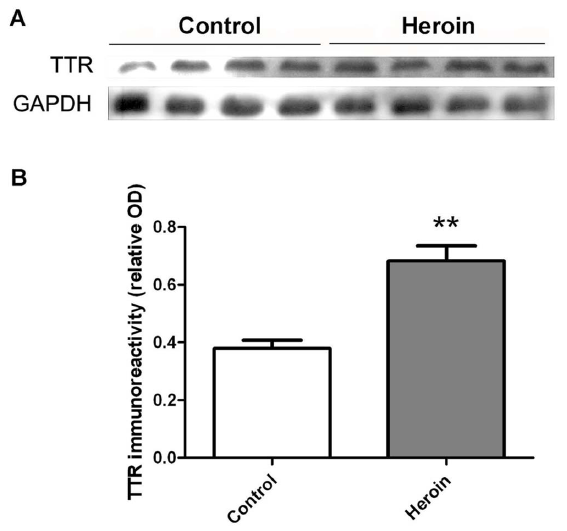
Figure 4. Western blot analysis of TTR in the serum of control and heroin addicts. (A) Representative blots showing relative amounts of TH and GAPDH in control and heroin addicts. (B) Statistical analysis of the relative optical density (OD) of the detected bands. Results are shown as means 6 S.E.M. from seven independent experiments. ** P , 0.01, v.s.